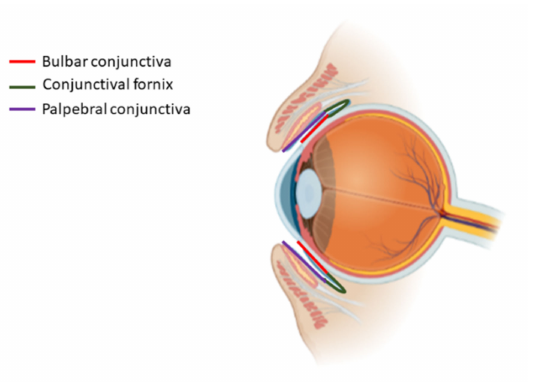
Figure 6. Schematic diagram of the conjunctiva showing its constitutive parts: bulbar conjunctiva (red), conjunctival fornix (green) and palpebral conjunctiva